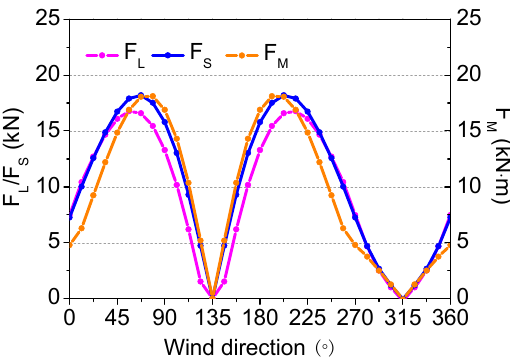
Figure 9. Impact of wind direction when a vehicle is travelling southeast at 40 km·h − 1 with a wind velocity of 18 m·s − 1 on aerodynamic forces: aerodynamic lift force ( F L , kN), lateral (or side) aerodynamic force ( F S , kN), and overturning moment ( F M , kN·m). Note that the meteorological convention for wind direction is used (i.e., northerly is 0°, increasing clockwise).